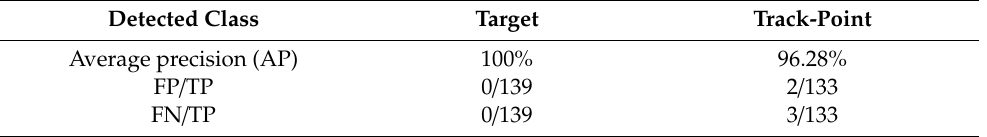
Table 3. The summary of network’s evaluation metrics.